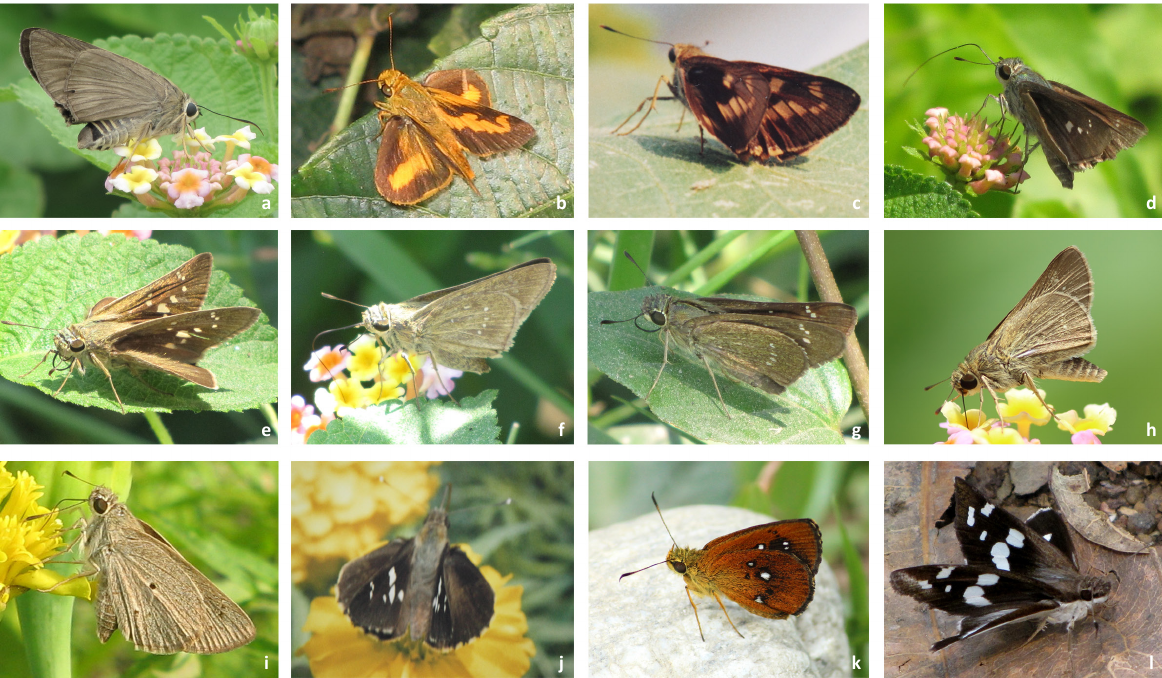
Image 1. Butterflies representing the family Hesperiidae in and around RRS, Chinsurah. a - Brown Awl B. exclamationis (Fabricius); b - Common Dartlet O. goloides (Moore); c - Plain Palm Dart C. acalle (Hopffer), d - Blank Swift C. Kumara (Moore); e - Conjoined Swift P. conjuncta (Herrich-Schaffer); f - Small Branded Swift P. mathias (Fabricius); g - Rice Swift B. cinnara (Wallace); h - Lesser Rice Swift B. bevani (Moore); i - Indian Palm Bob S. gremius (Fabricius); j - Tree Flitter H. adrastus (Stoll); k - Chestnut Bob L. salsala (Moore); l - Grass Demon U. folus (Cramer). © Somnath